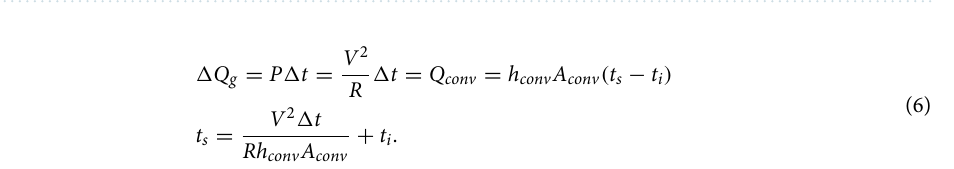
Figure 5. Temperature of the ZnO/metal/ZnO multilayer-based thin film heater depending on input DC